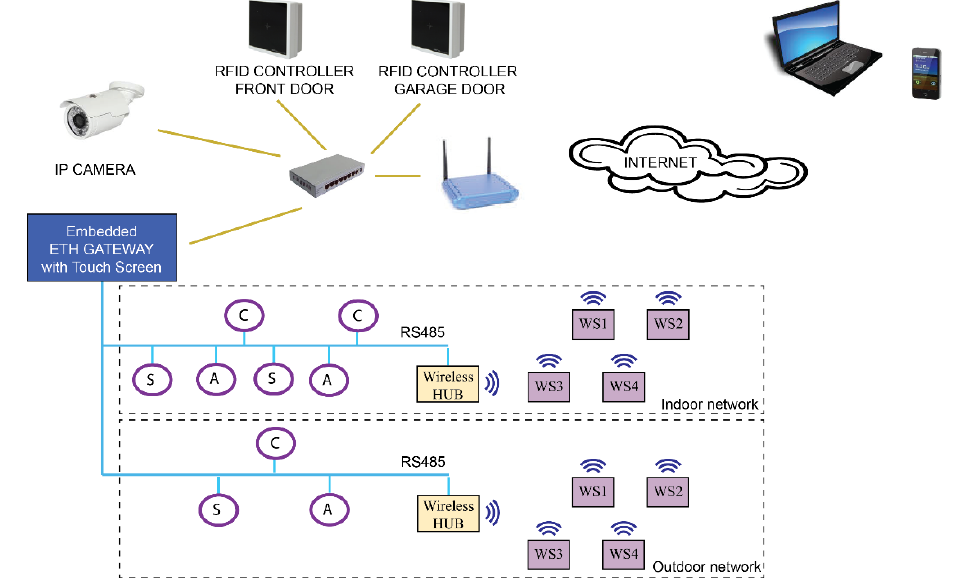
Figure 8. Structure of a typical Physis system (S—sensor, C—controller, A—actuator, WS—wireless sensor) (after Ref. [45]).